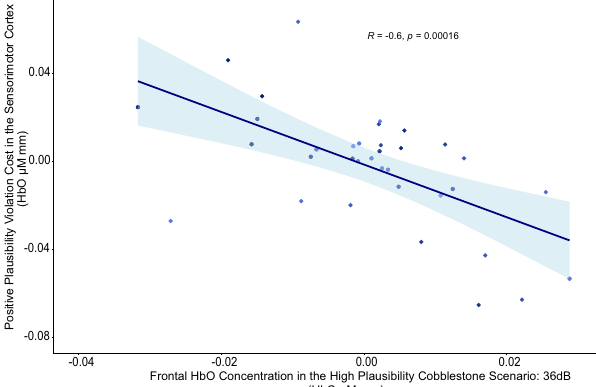
Fig. 4 Scatterplots showing positive correlations between plausibility violation costs in the somatosensory cortex and frontal regions. a Results regarding negative expectancy cost which was computed as the difference in HbO concentration between the scenarios of cobblestone 10dB and highway 10dB ( n = 35 young adults). b Results regarding positive expectancy cost which was computed as the difference in HbO concentration between the scenarios of highway 36dB and cobblestone 36dB. Shaded area represents the 95% con fi dence interval ( n = 36 young adults).